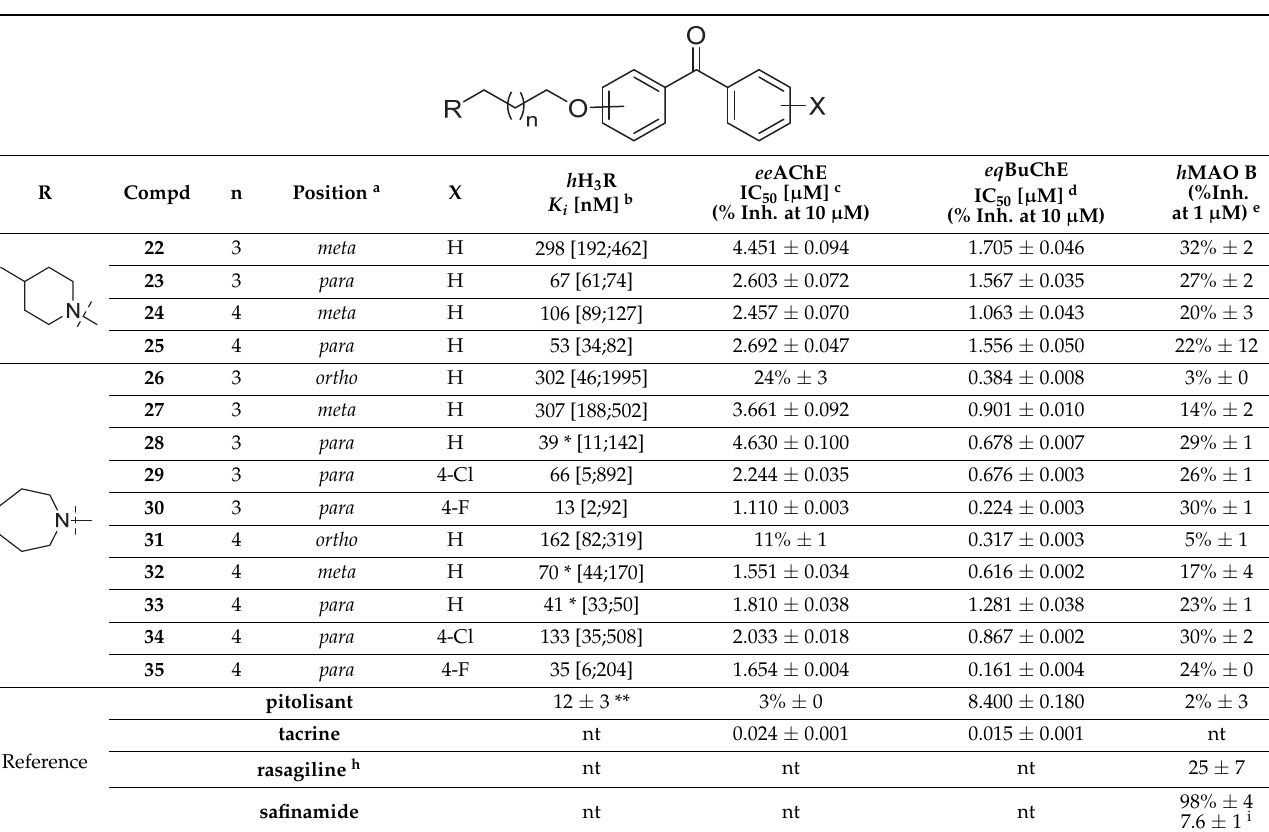
Table 1. Cont . Table 1. Structures and in vitro activity of tested compounds ( 2 – 35 ).